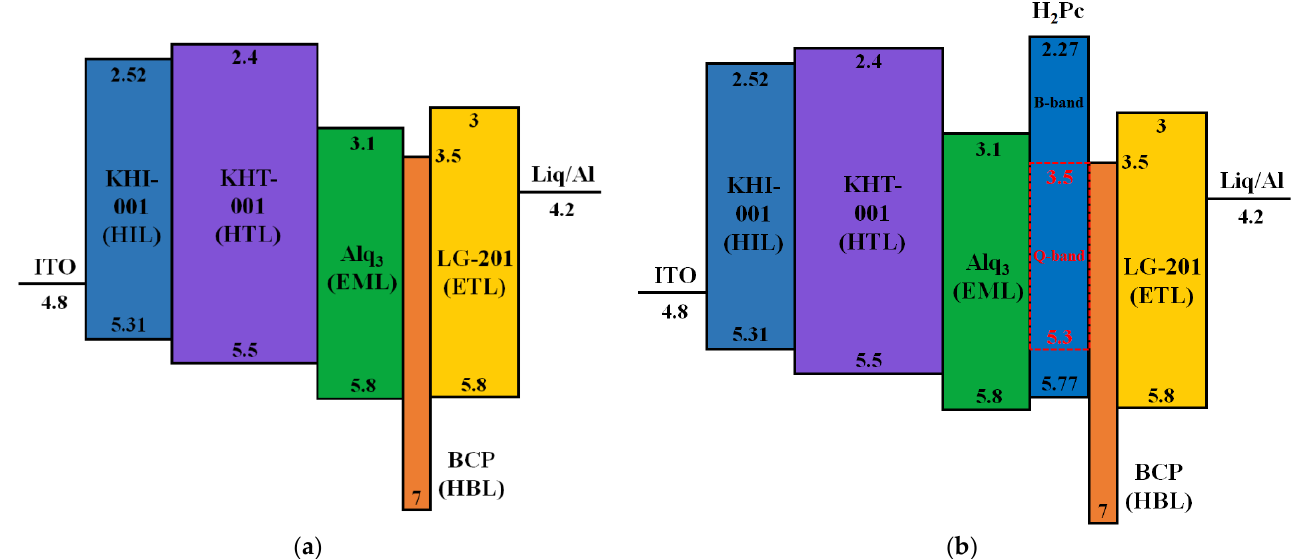
Figure 2. Energy band diagram of the CTOLED. ( a ) An OLED with only Alq 3 as the EML and ( b ) a CTOLED with H 2 Pc and Alq 3 as EMLs.